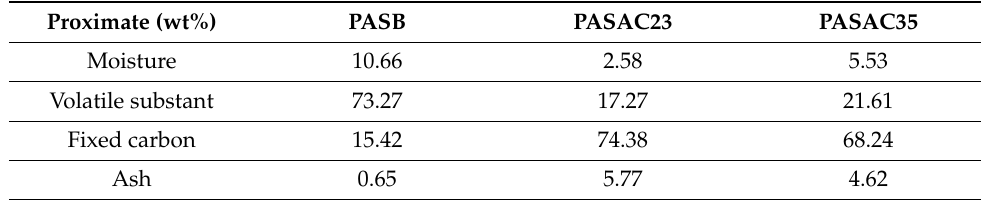
Table 2. Proximate analysis of PASB and PASACs.